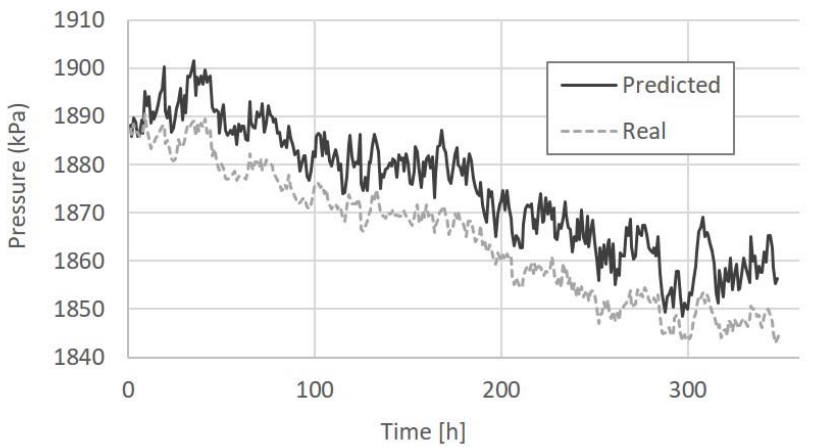
Figure 16. Predicted value of T3 vs. actual value.